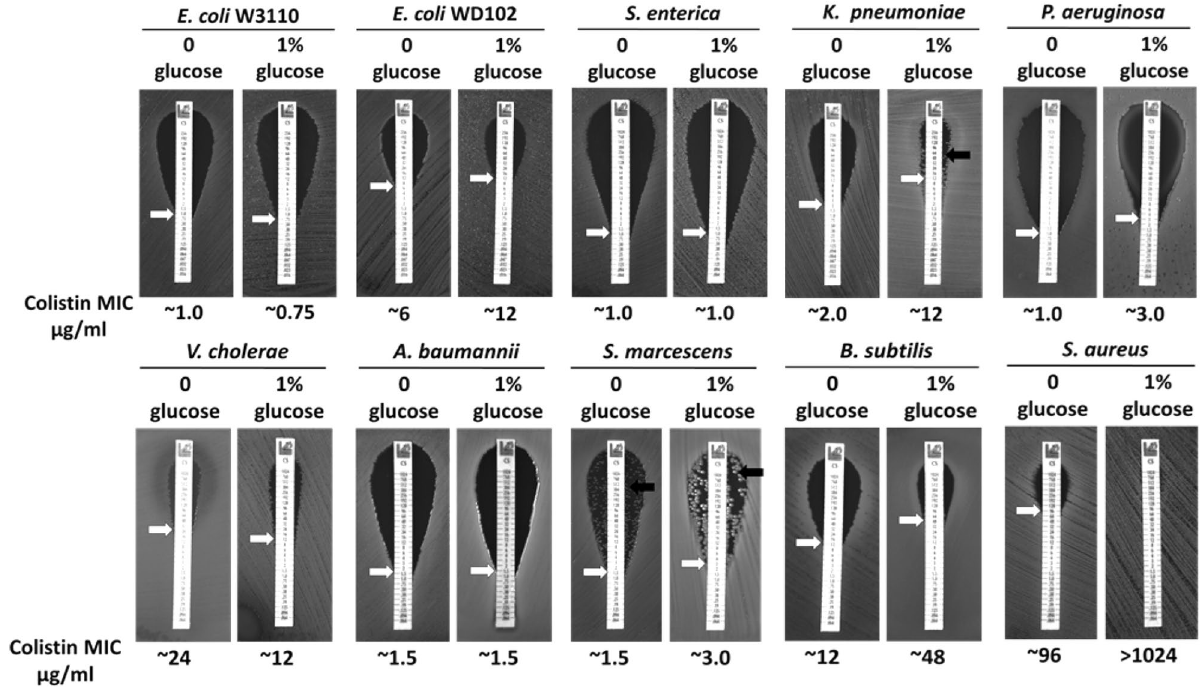
Figure 7. Effect of glucose supplementation in colistin MIC of different bacterial species. The colistin MIC was determined for indicated strains on LB agar plates with either 0% or 1% glucose. Plates were analyzed after 24 h of growth at 37 °C. Approximate MICs are denoted by white arrows. A black arrow represents heteroresistant colonies of S. marcescens or K. pneumoniae